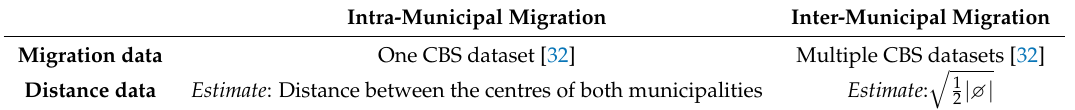
Table 1. Sources for the values of the different variables used in the regression.